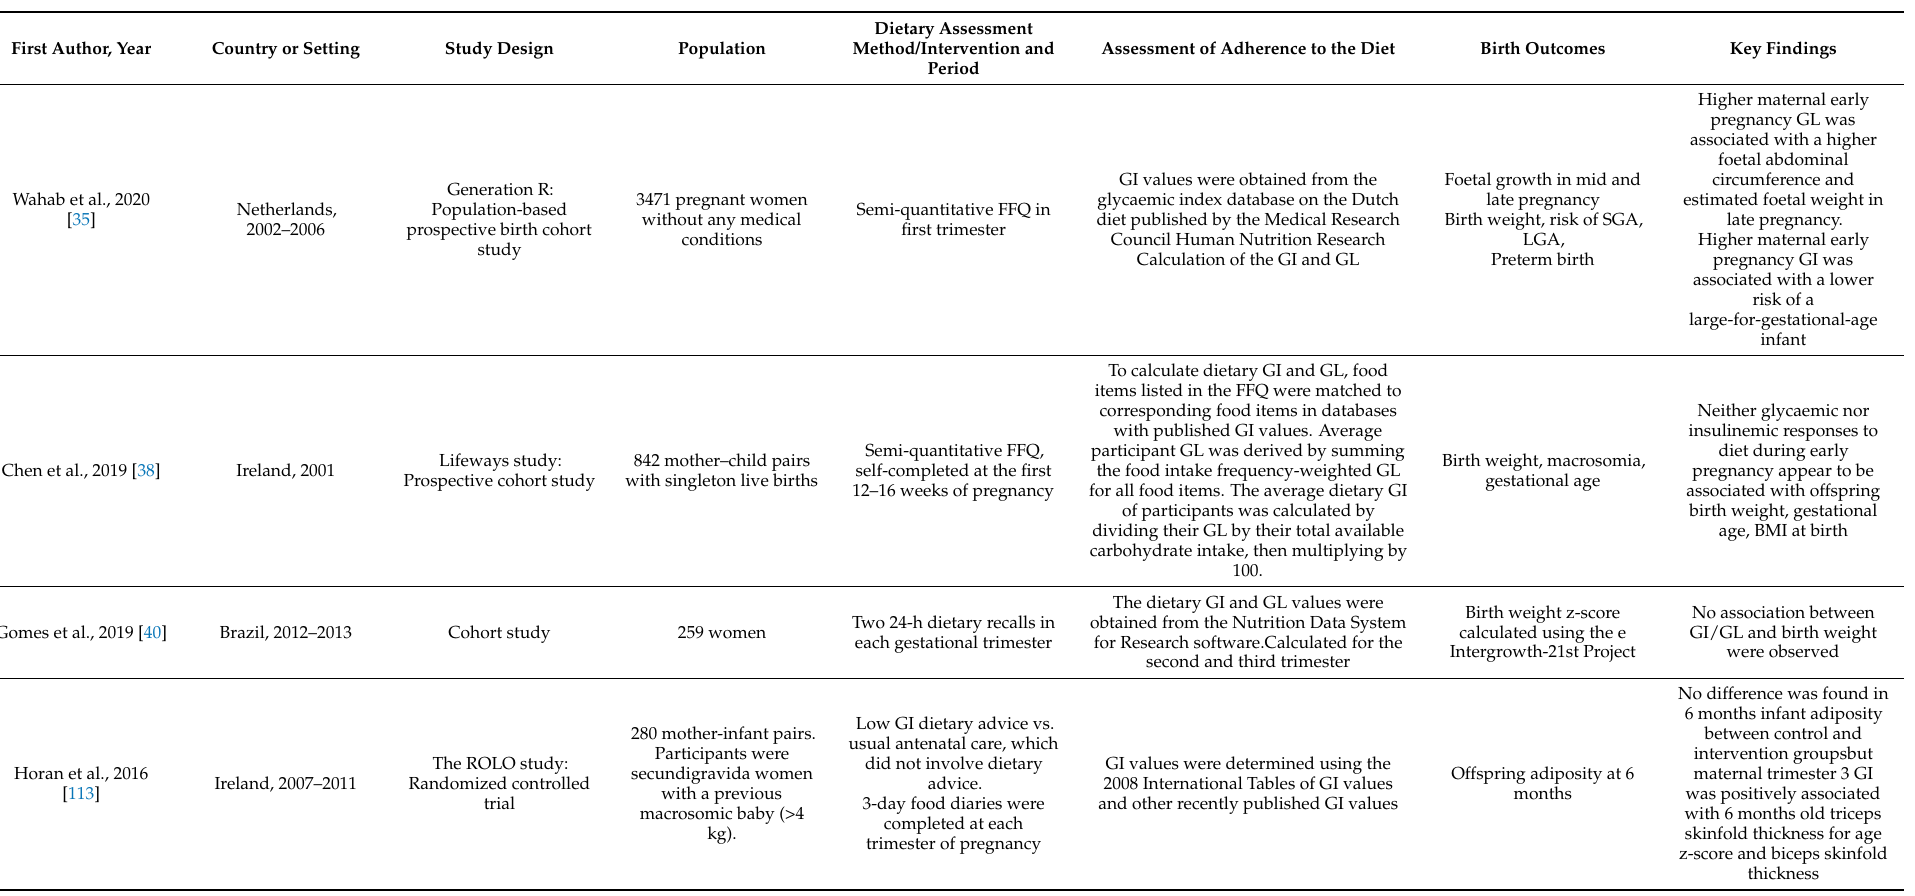
Table 6. Individual studies on the associations between maternal glycaemic index and birth